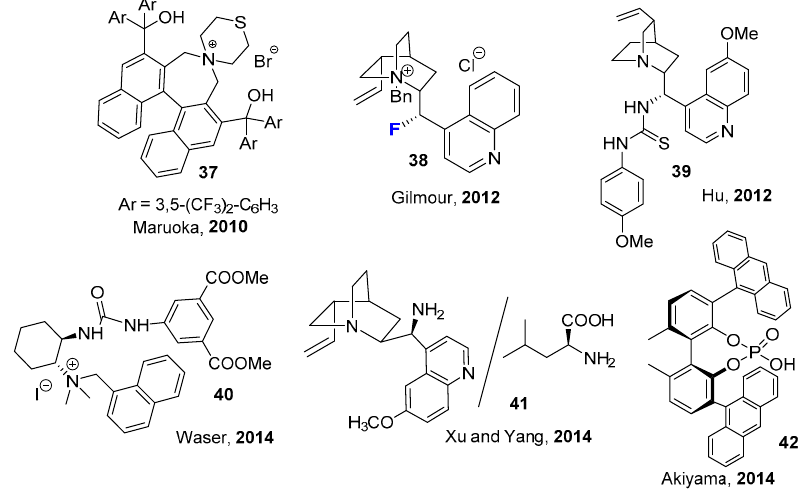
Figure 6. Structure of different organocatalysts.